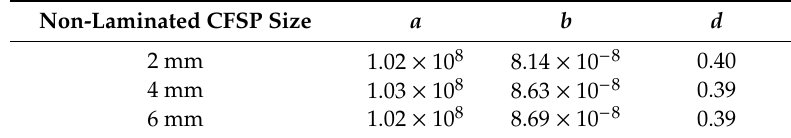
Table 3. Fitting coe ffi cients of non-laminated CFSP paper by our model.